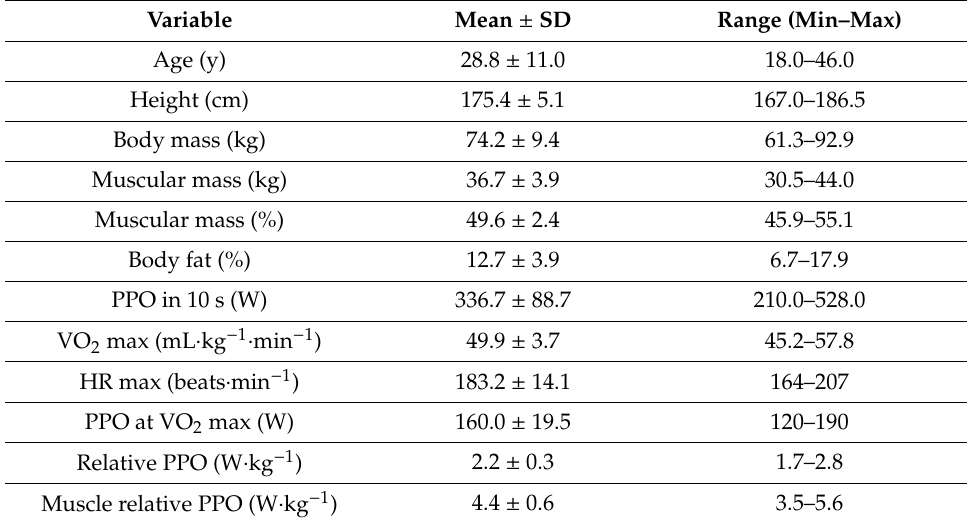
Table 1. Participants’ age, body composition, and athletic performance characteristics ( n =